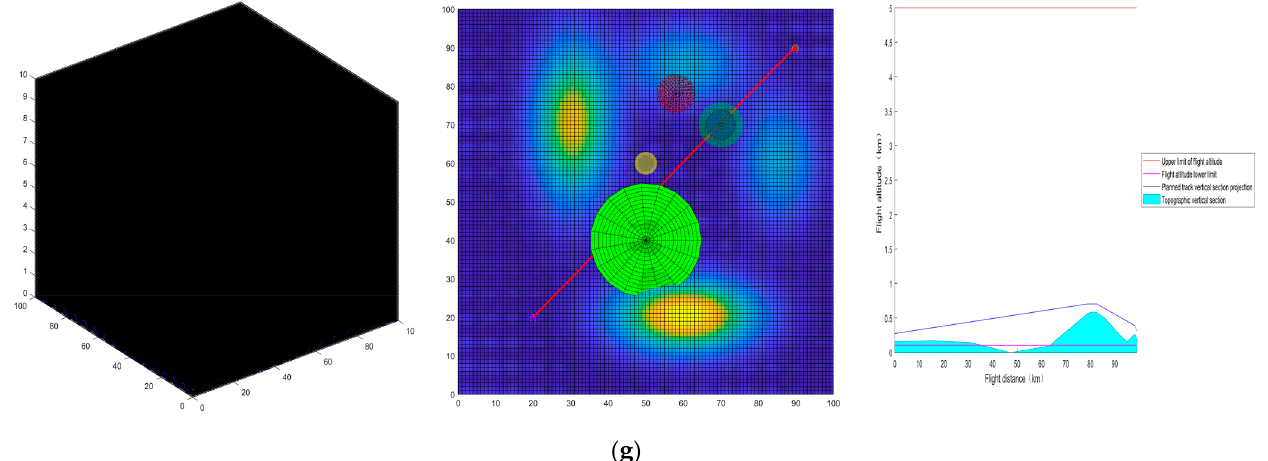
Figure A5. Lazy Theta* route planning at different grid levels. ( a ) N = 3, ( b ) N = 4, ( c ) N = 5, ( d ) N = 6, ( e ) N = 7, ( f ) N = 8, and ( g ) N = 9.